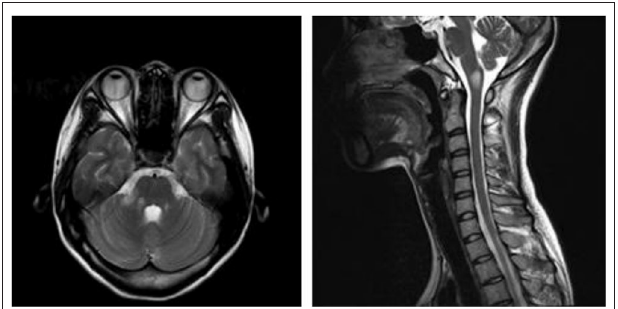
FIGURE 1 | T2-hyperintense lesions in the dorsal medulla oblongata and right middle cerebellar